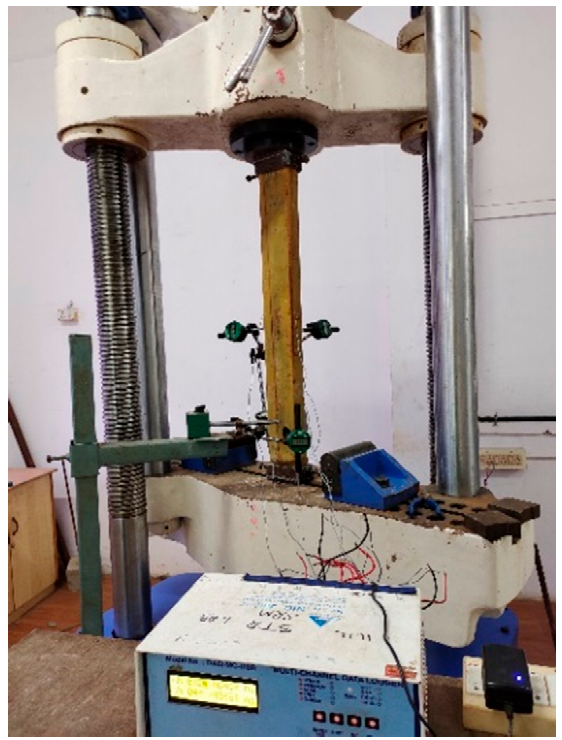
Figure 13. Failure in short columns.